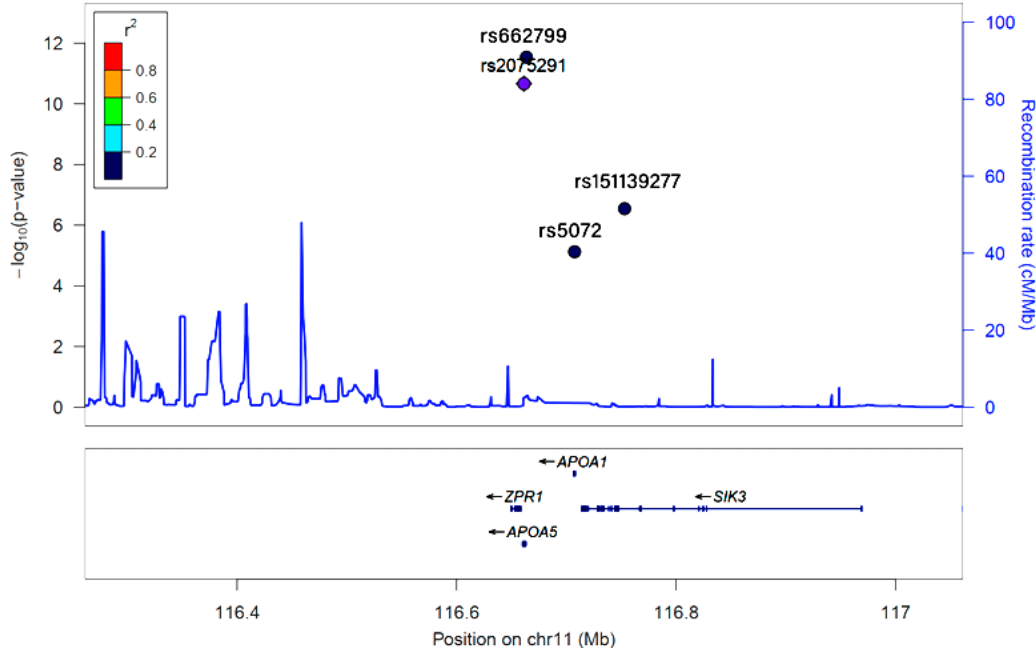
Figure 2. Linkage disequilibrium (LD) of KCNQ1 _rs2237892, ZPR1 _rs2075291, APOA5 _rs662799, APOA1 _rs5072, and SIK3 _rs151139277, as determined by Locus Zoom.